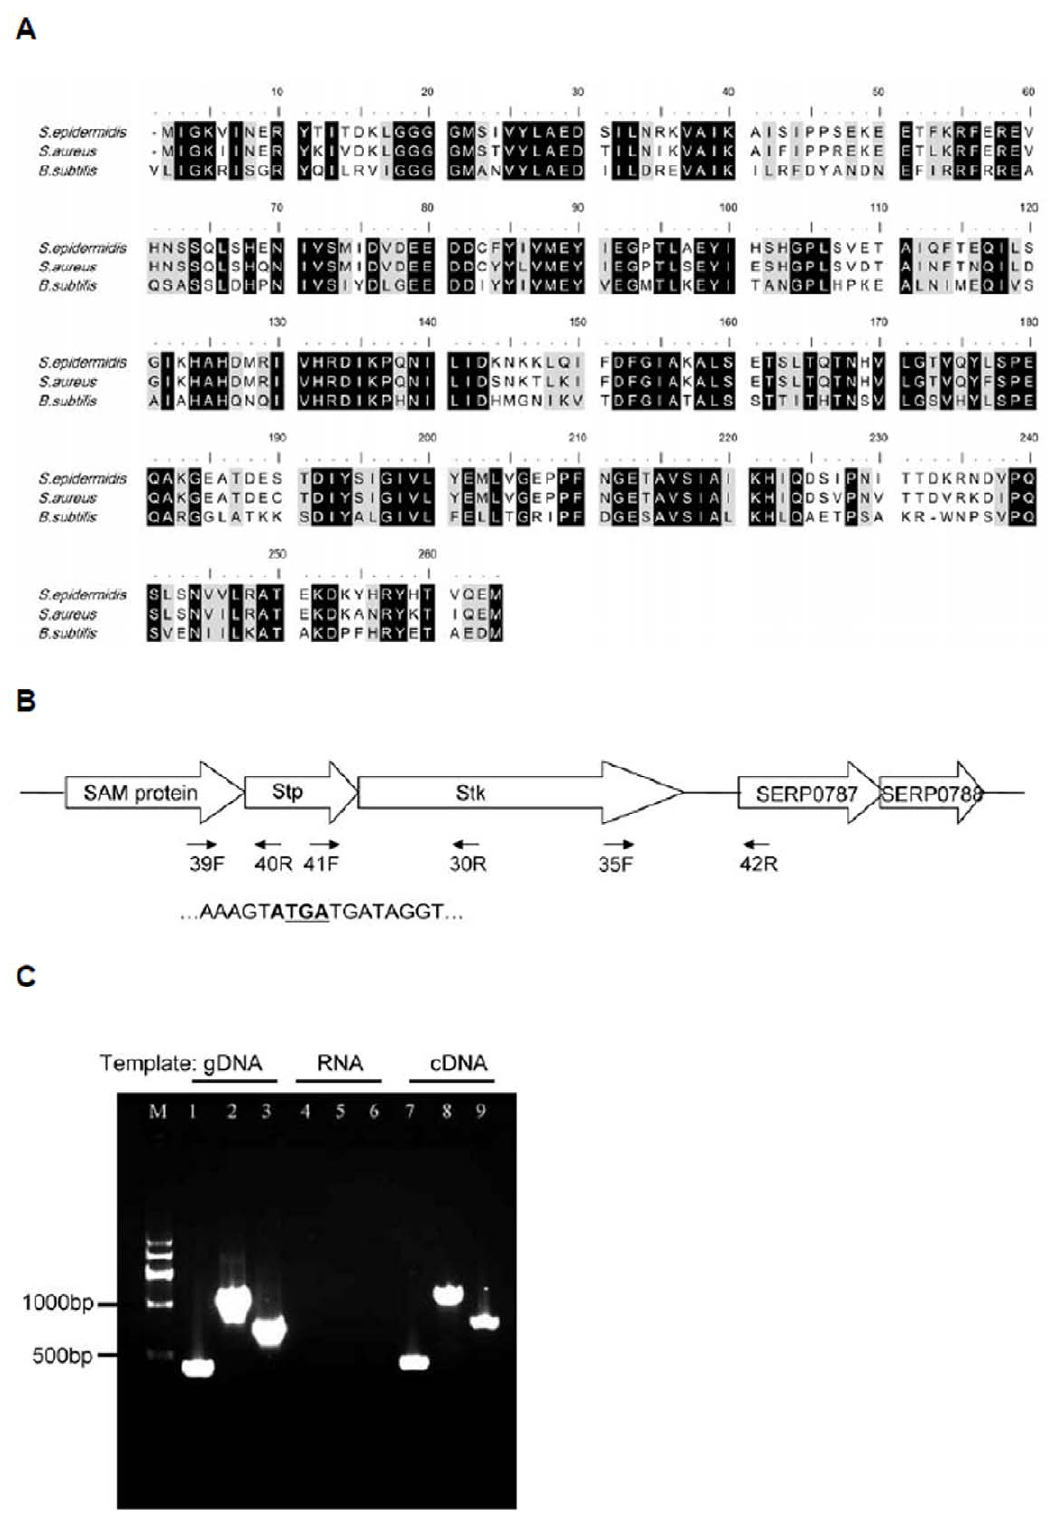
Figure 1. The genomic context of stk and stp in S.epidermidis . A. Alignment of stk sequences of S. epidermidis 1457 with those of S. aureus and B. subtilis , showing conserved amino acid positions at the bottom. B. Schematic of the stk/stp genetic locus showing primer annealing sites. The four nucleotides by which the two genes overlap are in bold. The stop codon for stp is underlined. C. Co-transcription analysis of the four genes SERP0784 to SERP0787 using reverse transcription (RT-) PCR analysis with genomic DNA (gDNA), RNA or cDNA as templates. Lanes 1, 4, and 7 represent the amplification using primer set 39F and 40R, lanes 2, 5, and 8 represent the amplification using primer set 41F and 30R, lanes 3, 6, and 9 represent the amplification using primer set 35F and 42R. doi:10.1371/journal.pone.0025380.g001 PLoS ONE | www.plosone.org